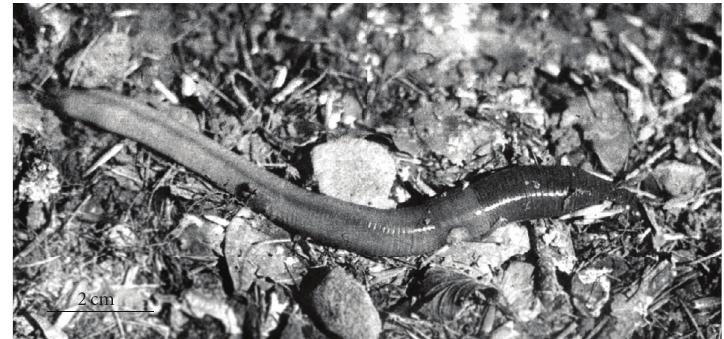
Figure 6: Photograph of a giant Black Forest earthworm (adult individual of Lumbricus badensis ) in its natural habitat. Note that the worm is anchored with its anterior body part in its burrow (adapted from [36]).